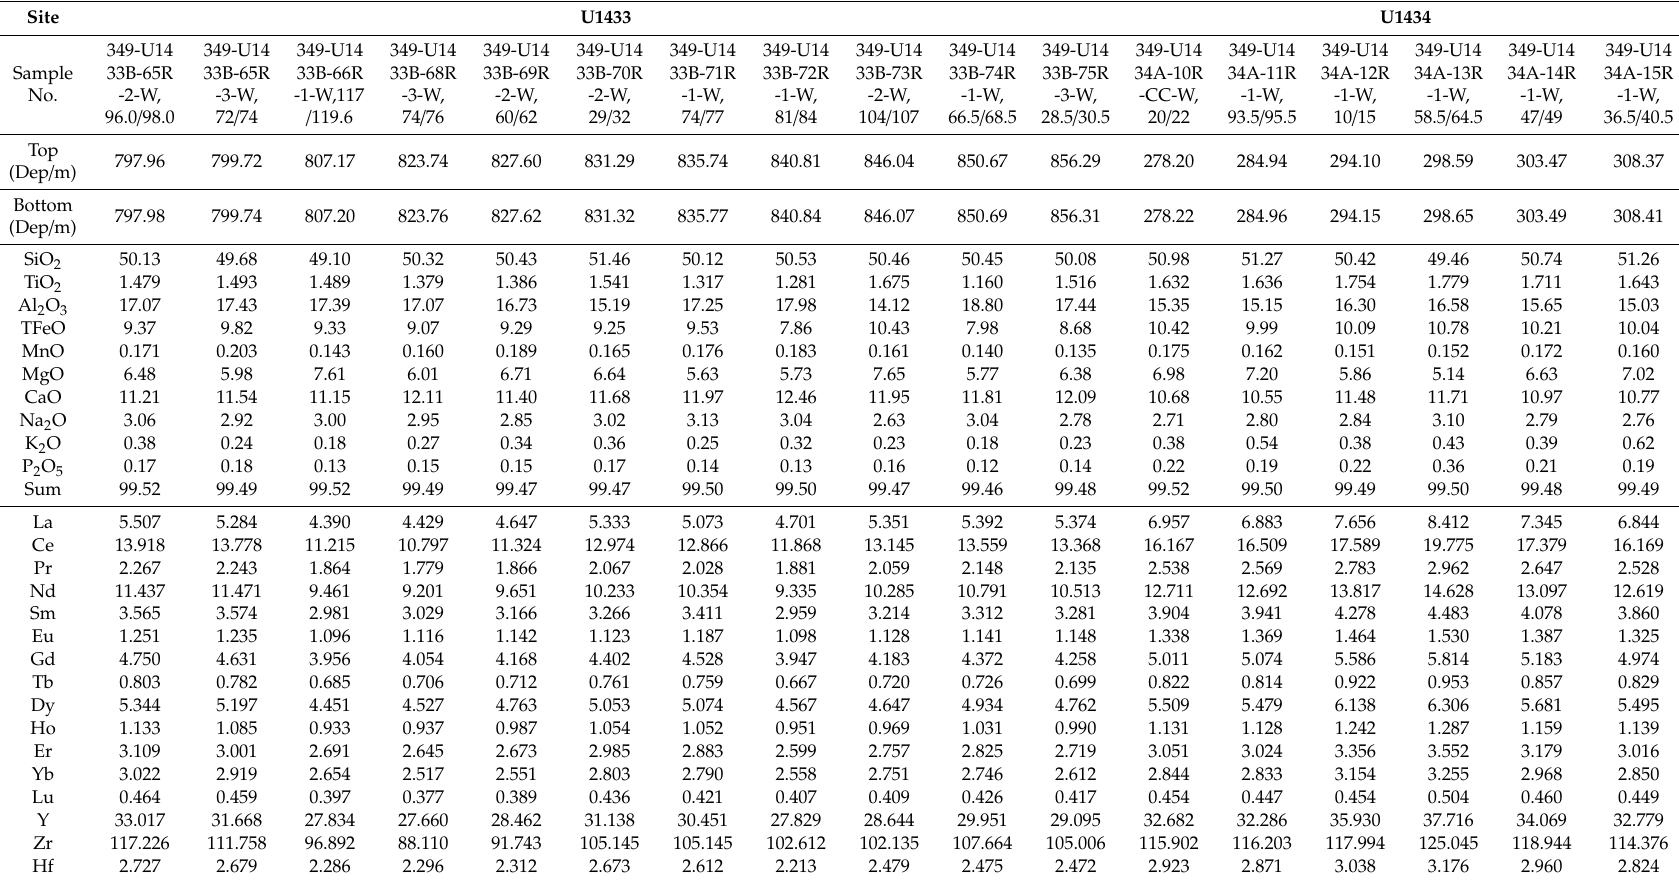
Table 1. Major (wt.%) and trace element (ppm) concentrations of basaltic samples at Sites U1433 and